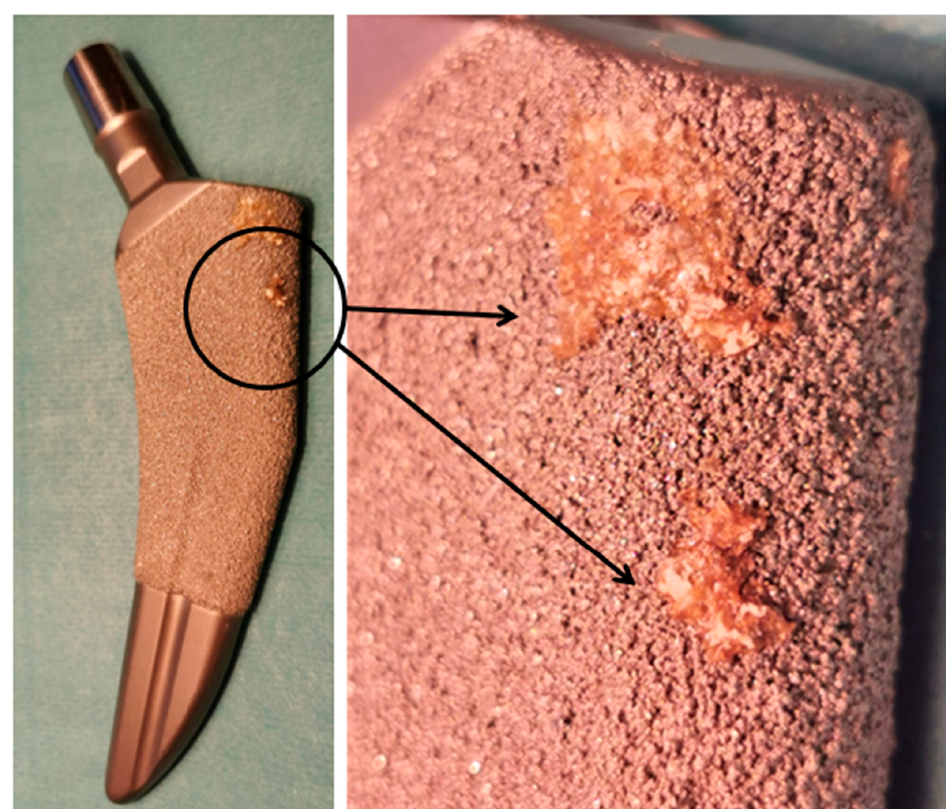
Figure 4. Osseointegration of the bone with implant’s titanium, porous plasma-sprayed surface (stem of the hip prosthesis; TaperLoc, Zimmer Biomet, Zug, Switzerland). Titanium nitride (TiN) coating smoothens, hardens, and enhances abrasion and cor- rosion resistance of the implant’s surface decreasing its wear and deformation, when loaded. It shares properties with deeper situated materials enabling lowering cost of man-